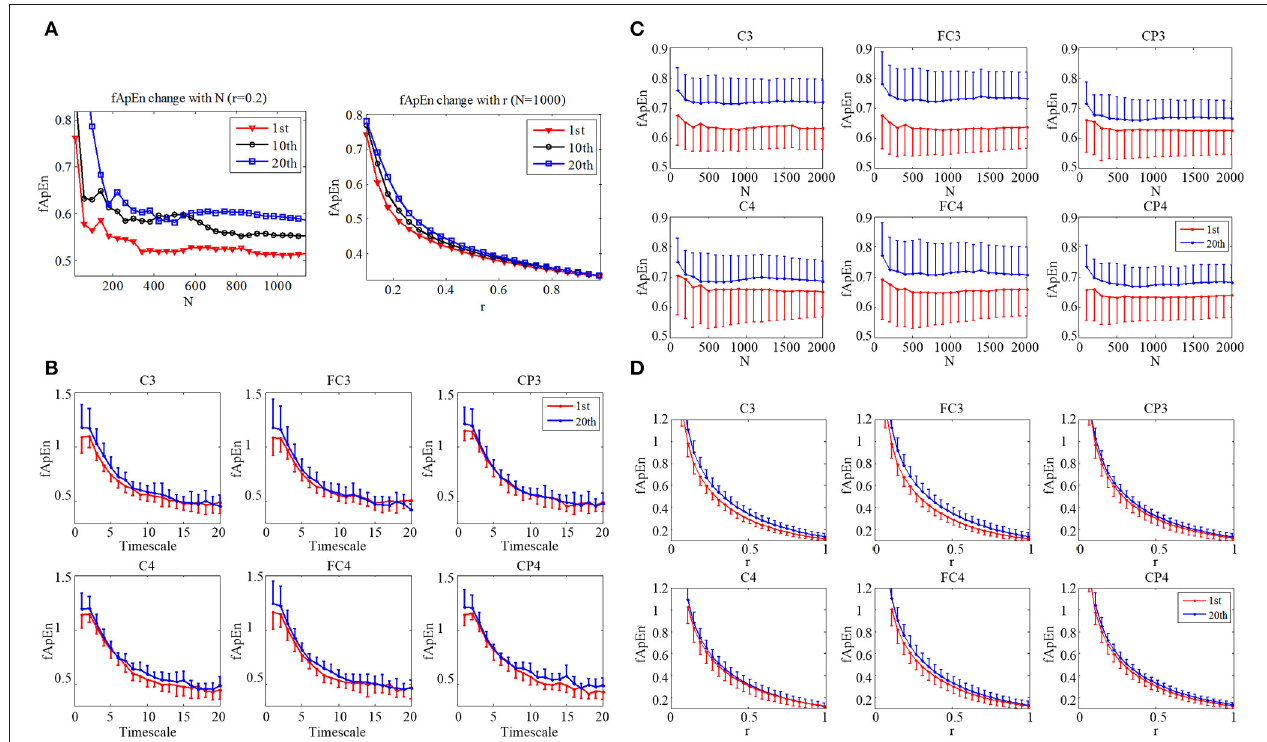
FIGURE 4 | (A) Change of EEG fApEn with increase of window N, and tolerance r in the 1st, 10th, and 20th training session in a subject (S3). (B) Average multiscale fApEn of EEG of 11 stroke subjects at six electrodes (C3, C4, FC3, FC4, CP3, CP4). Average change of EEG fApEn with increase of (C) window N and (D) tolerance r of 11 stroke subjects at six